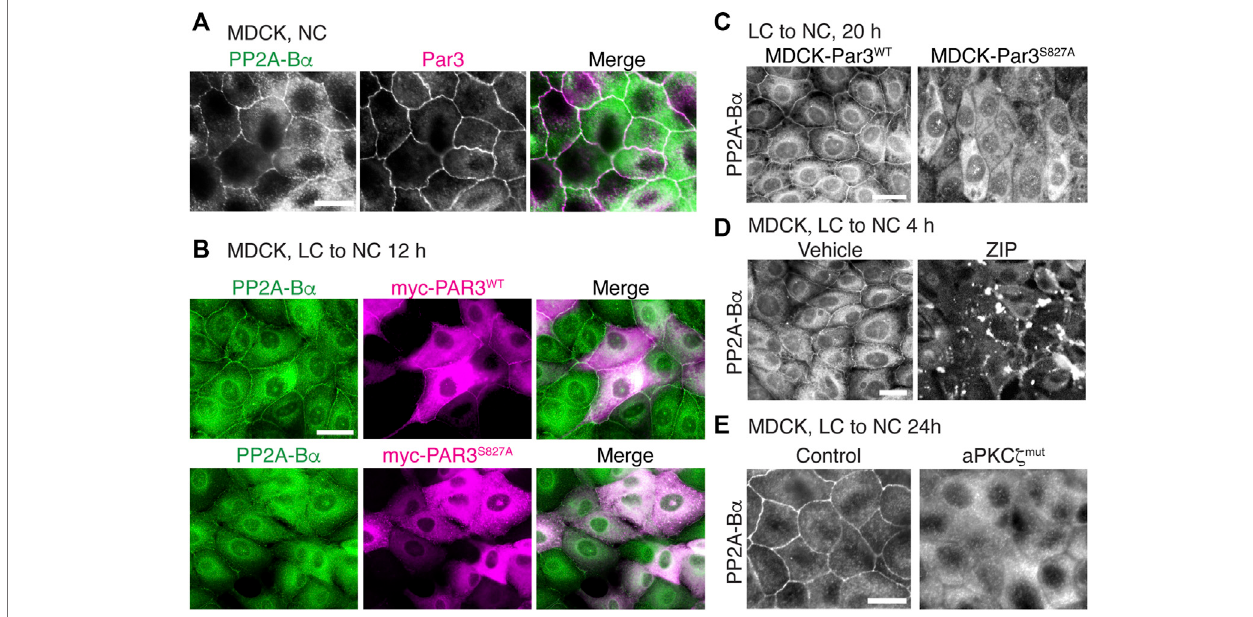
FIGURE 8 | Interfering with aPKC ζ -dependent phosphorylation of Par3 affects the targeting of AB α C to the TJ. (A) Co-localization of endogenous PP2A-B α and Par3 in con fl uent MDCK cells labeled with anti-B α and anti-Par3 antibodies. (B) Comparative distribution of PP2A-B α in MDCK cells transiently transfected with Par3 WT or the Par3 S827A mutant, 12 h after a Ca 2+ switch. Note that PP2A-B α is present at the junctions between cells expressing Par3 WT , but not Par3 S827A . (C) Comparative distribution of PP2A-B α in stable MDCK-Par3 WT and MDCK-Par3 S827A cells, 20 h after a Ca 2+ switch. (D) Distribution of PP2A-B α in MDCK cells switched for 4 h from LC to NC medium in the presence of 50 μ M ZIP or vehicle. (E) PP2A-B α is distributed at cell-cell junctions in control MDCK, but not in MDCK-aPKC ζ mut cells, 24 h after a Ca 2+ switch. For (A – E) , representative images from three separate experiments are shown. Scale bars = 10 μ